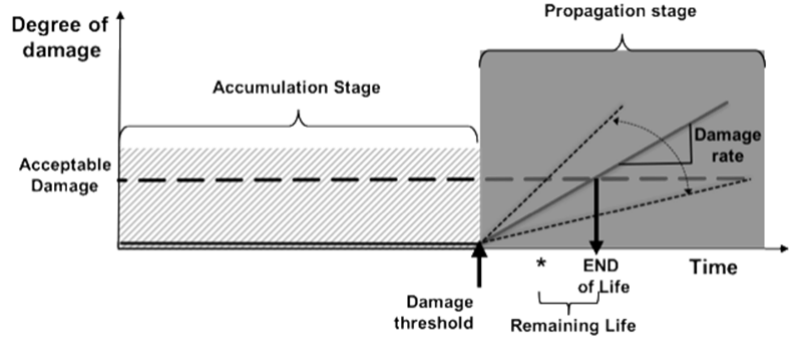
Figure 6. Schematic representation of durability of a stone subject to salt damage, adapted from the concept proposed by Tuutti to describe the durability of reinforced concrete [93]. The graph shows a first “accumulation phase”, during which salts deposit in the porous material, but are not yet present in large enough amounts to damage it. Damage starts to develop after the “damage onset” and progresses at the “damage rate”. Stones may however remain in place until a level of “acceptable damage” is exceeded. If confronted in knowing how much more time a degrading stone may be left in place beyond at certain time (marked by “*” in the graph), then the value of the “damage rate” is the most important factor in determining the “remaining service life”. If the question concerns the selection of the most adequate replacement material, then the “service life” will most probably be conditioned by the “accumulation stage” and laboratory testing should focus on this rather than on damage